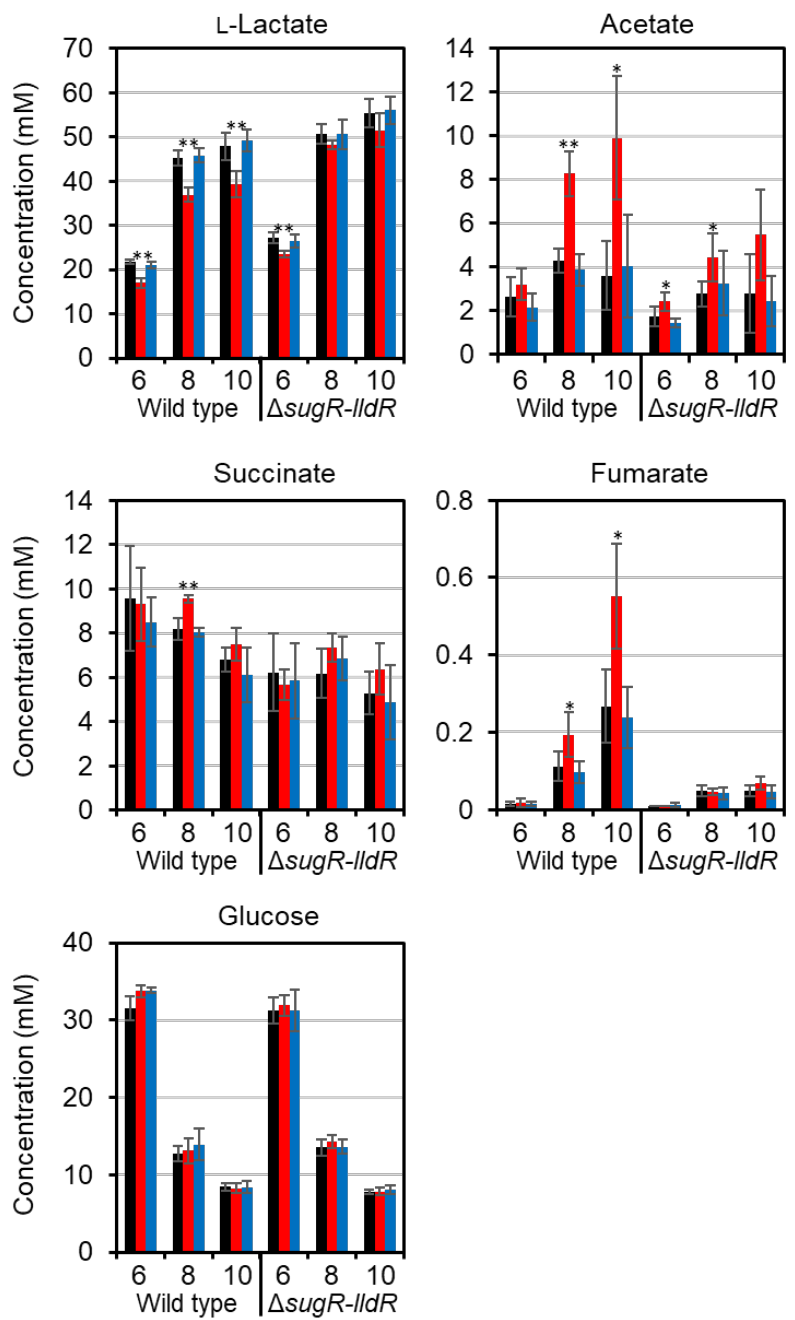
Figure 6. Organic acids and glucose in culture supernatants. The wild type and sugR – lldR deletion mutant with the native (black), mut1 (red), or mut2 (blue) GlxR-binding site in the ldhA promoter were grown in A medium supplemented with 1% glucose. The culture supernatants at 6, 8, and 10 h were analyzed. Mean values obtained from at least three independent cultivations are shown with their standard deviations. p -values were calculated using an unpaired t -test. (*) p < 0.05; (**) p < 0.01 (comparison with the parental wild type).